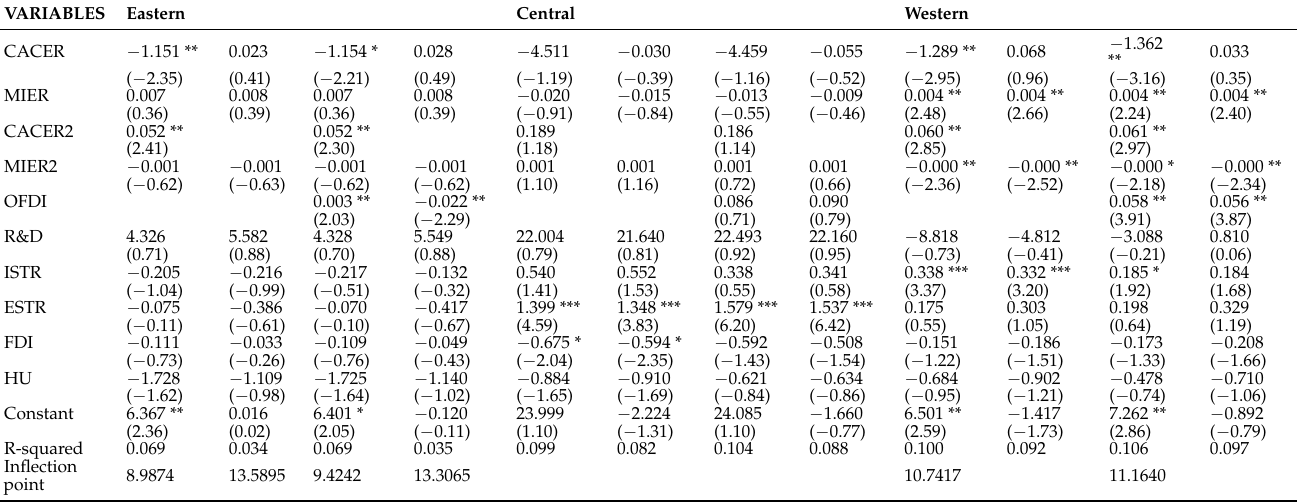
Table A6. Estimated results of the impact of ERs and OFDI on GTFP across regions (FE